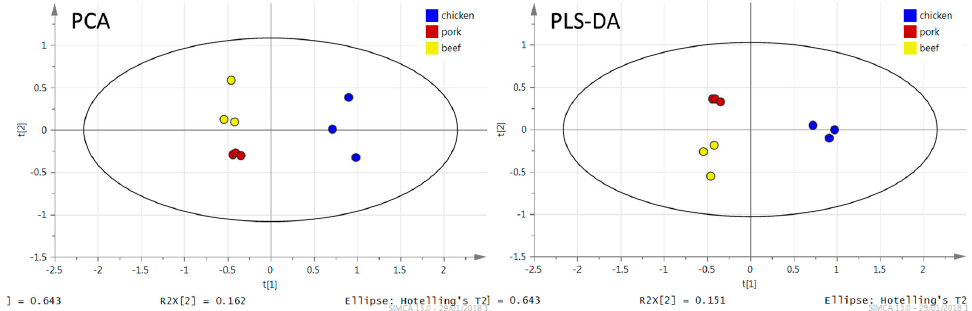
Figure 2. Principal component analysis (PCA) and partial least squares discriminant analysis (PLS-DA) plot created from ions related to triacylglycerols present in hexane extracts of chicken meat (blue), pork (red) and beef (yellow).